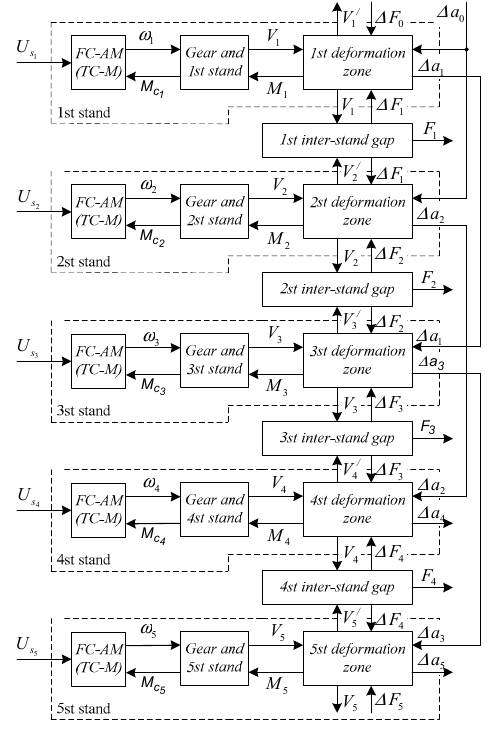
Figure 6. Structural diagram of a mathematical model of a continuous five-stand mill with four-roll passes.